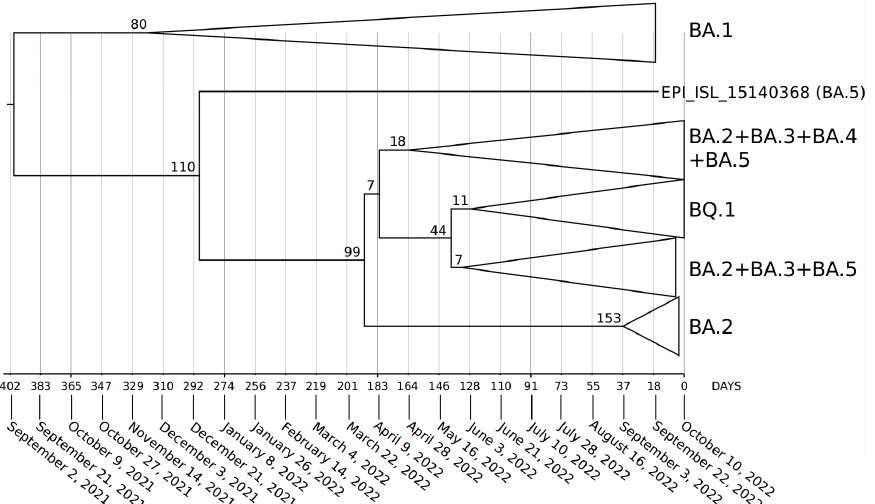
Figure 2. Maximum clade credibility tree estimated from 1575 whole genomes of BQ.1, BA.1, BA.2, BA.3, BA.4, and BA.5 downloaded from the GSAID portal (https://gisaid.org/), available on 15 October 2022. See Table S1 for details on the genomes included in the analyses. All showed nodes are well-supported, and the values of posterior probabilities for all the nodes are between 0.95 and 1 (PP ≥ 0.95). The bar under the tree indicates the time scale expressed in days before 10 October 2022, which represents the most recent sampling date included in the analyzed dataset. Node values indicate branches time expressed in days.